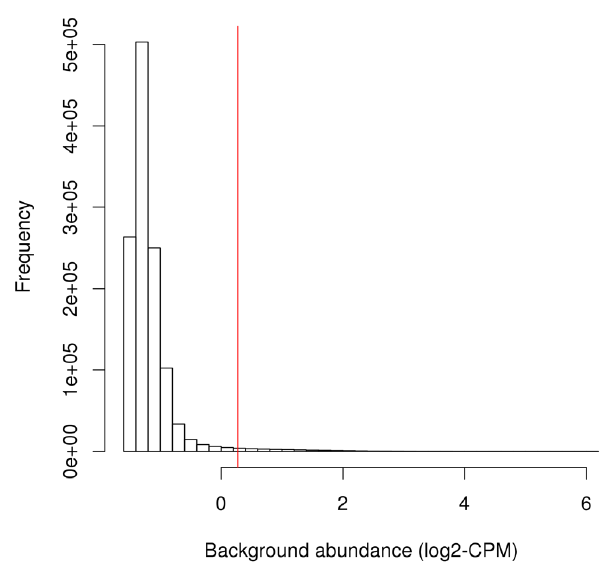
Figure 2. Histogram of average abundances across all 2 kbp genomic bins. The filter threshold is shown as the red line. Normalizing for library-specific trended